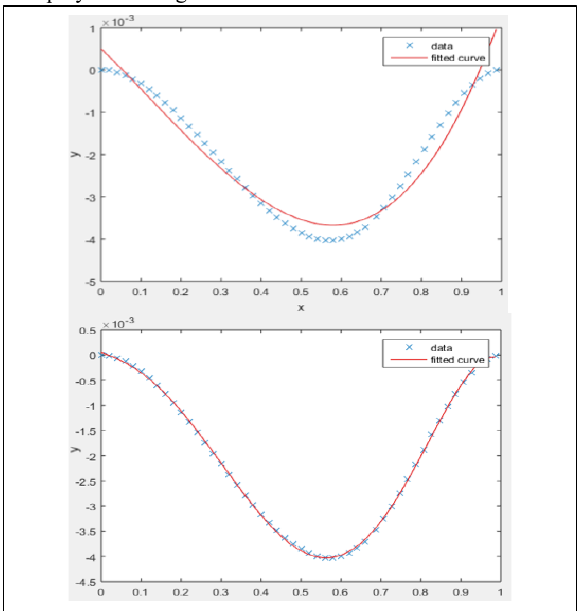
Figure 1. Comparison of point beam profile and fitted curves: Fitting to a third degree polynomial (top) and fitting to a fifth degree polynomial.